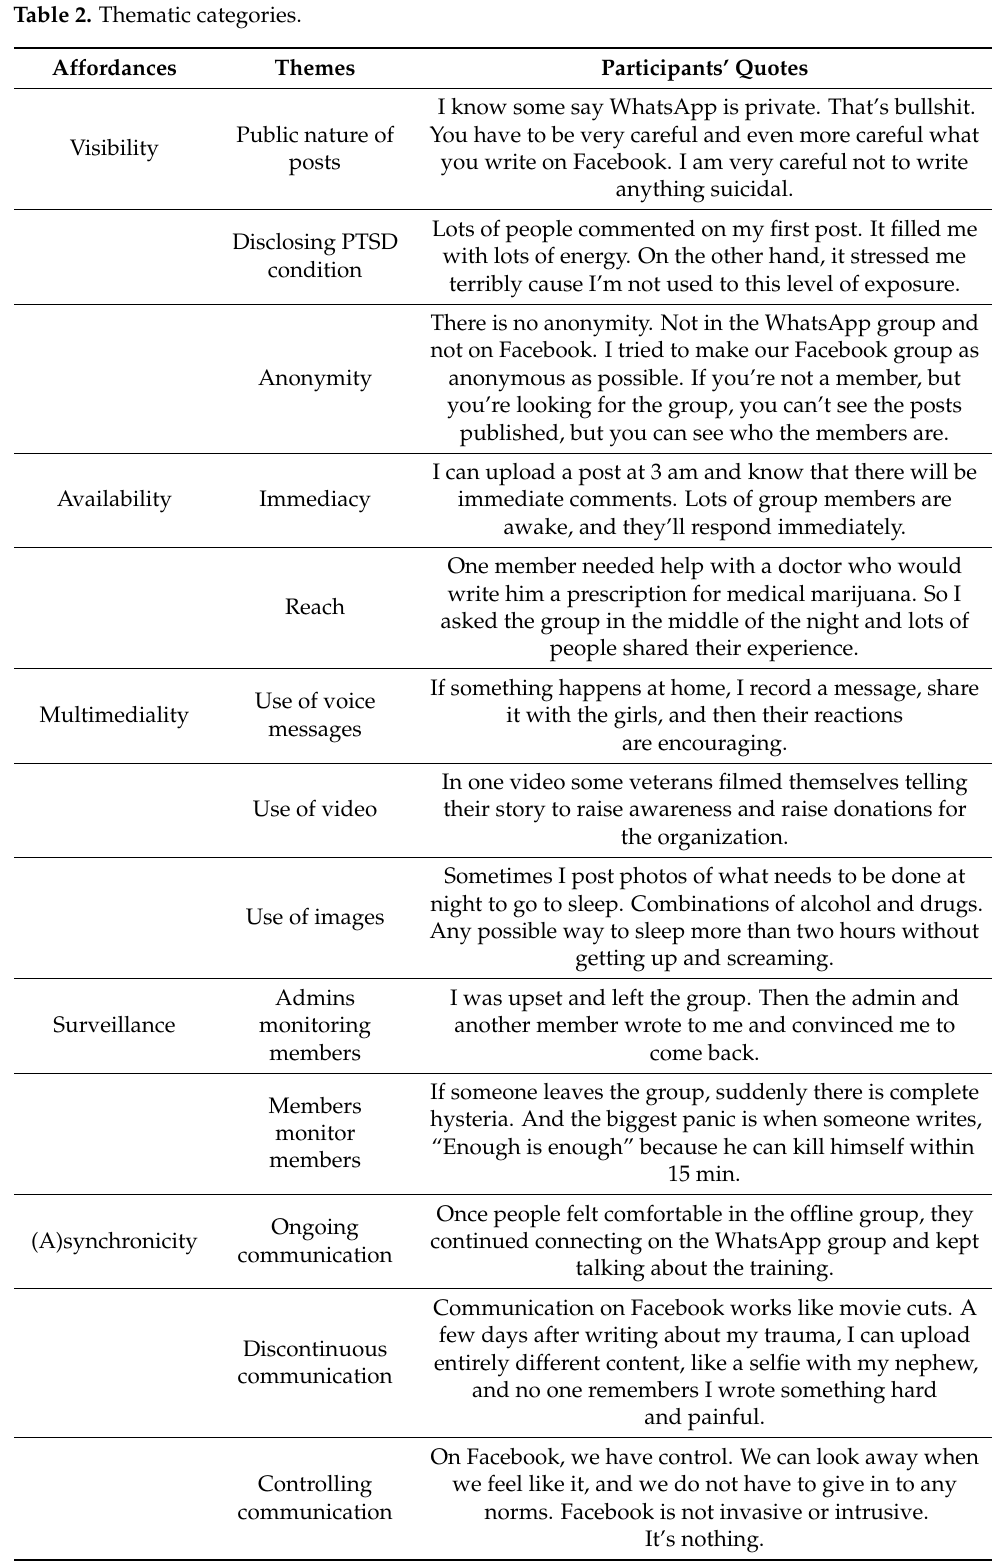
Table 2. Thematic